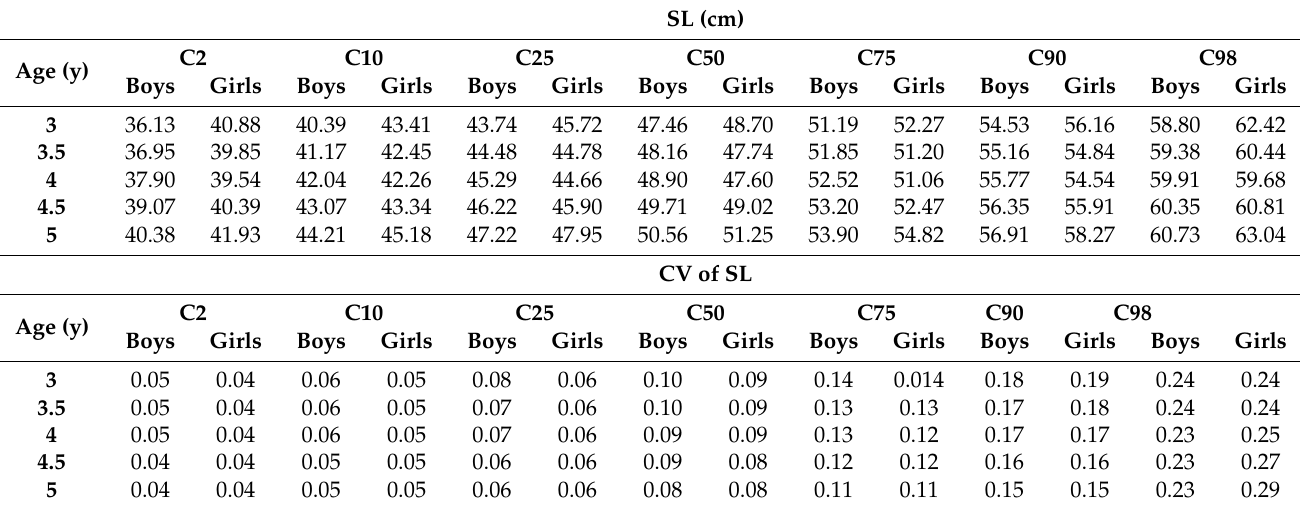
Table 3. Centiles of SL and CV by age and